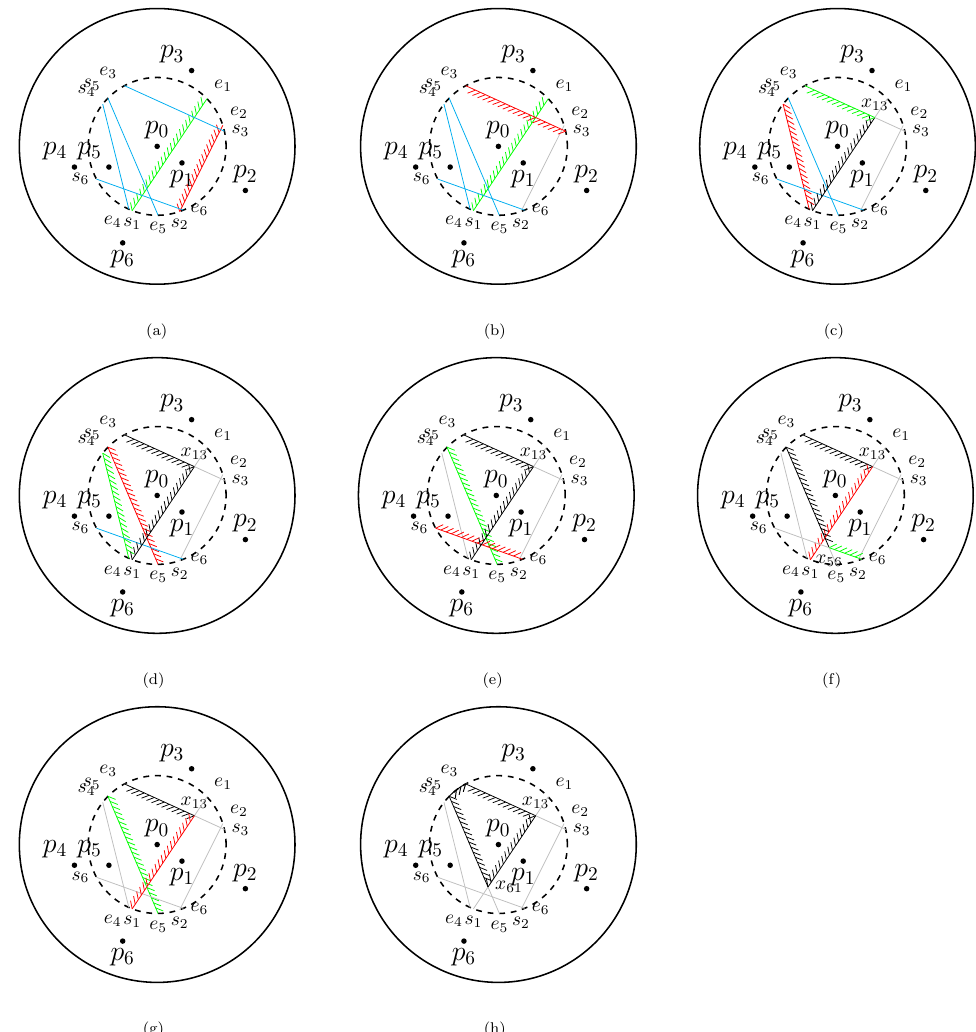
Figure 4. The sequential implementation of the BS